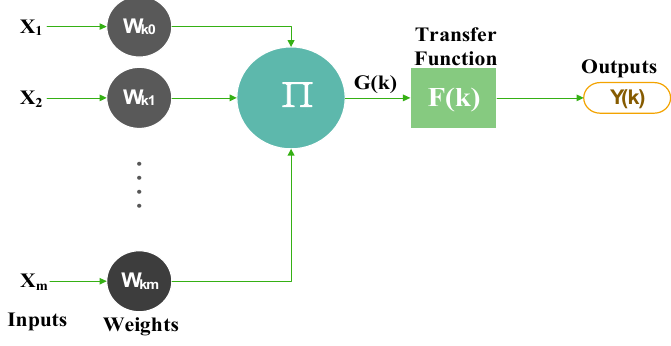
Figure 4. ANN Basic Architecture.